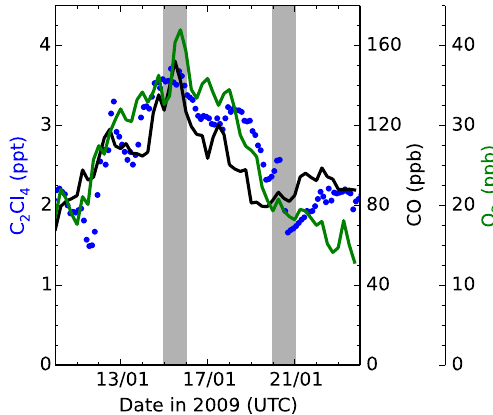
Figure 3. Time series of 3h mean C 2 Cl 4 measurements from Bukit Atur (blue) and 6-hourly CO (black line) and O 3 (green line) at 118 ◦ E, 5 ◦ N, 925hPa in the MACC reanalysis. The days analysed in more detail in Fig. 4 are shaded